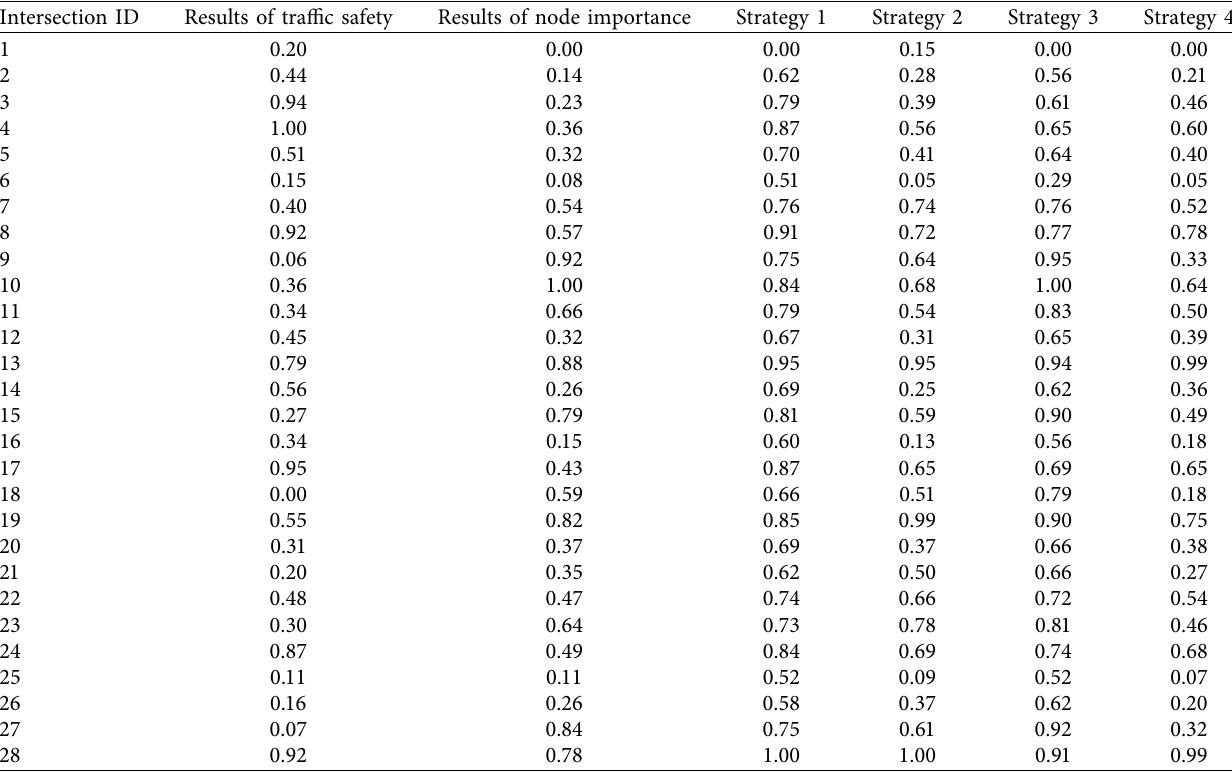
Table 3: The results of intersection